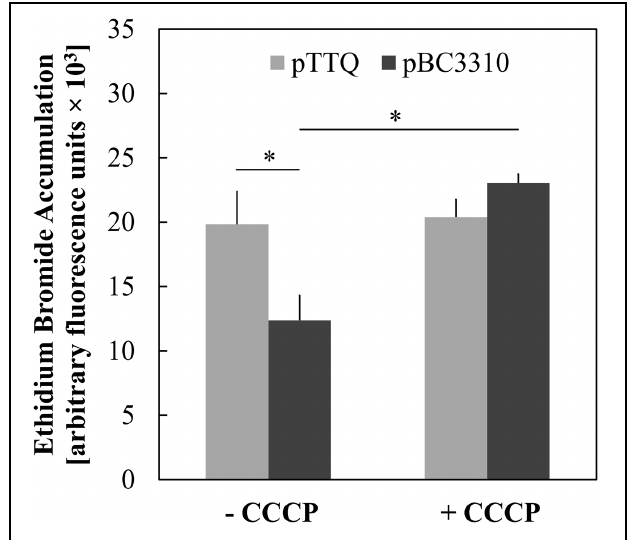
FIGURE 4 | Uncoupler-sensitive efflux of ethidium associated with expression of BC3310. Accumulation of ethidium bromide after 30 min was measured in IPTG-induced E. coli DH5 α (cid:2) acrAB host cells either expressing bc3310 (pBC3310, dark gray) or not using an empty vector control (pTTQ18, light gray) without (-CCCP) and with addition of CCCP ( + CCCP). Values are means of four independent experiments and error bars indicate standard deviations, ∗ p < 0.01, unpaired Student’s t